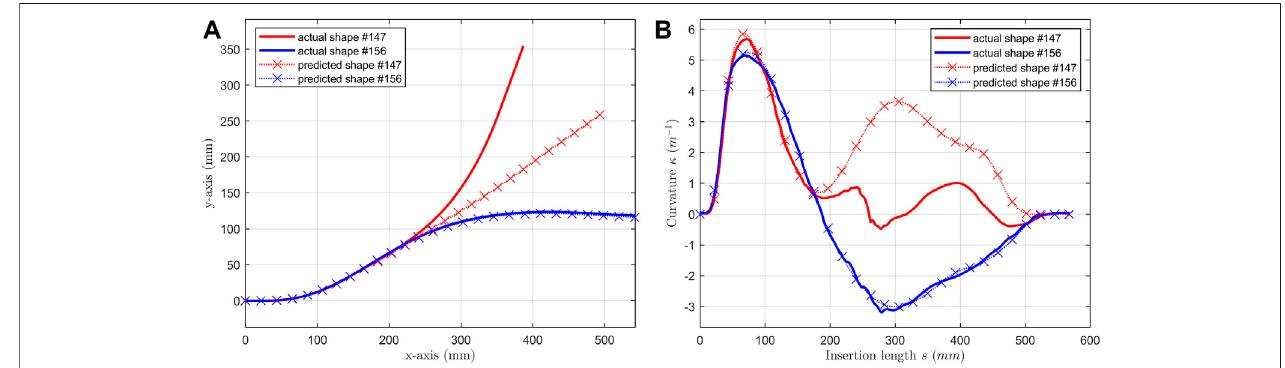
FIGURE 10 | For shape #147 & #156, (A) predicted shapes are compared with actual shapes; (B) predicted curvatures are compared with actual curvatures.